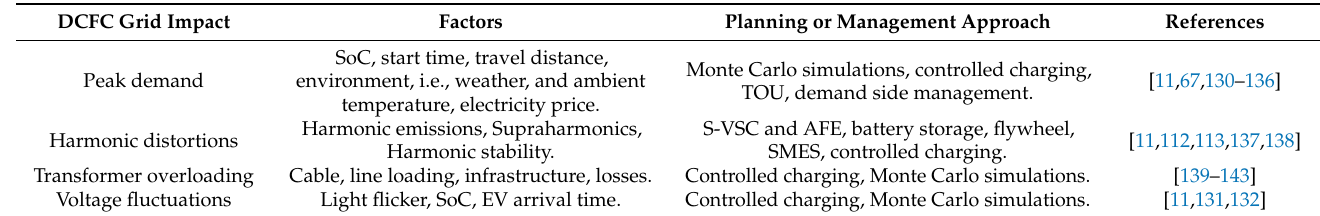
Table 3. DC fast charging grid impacts and